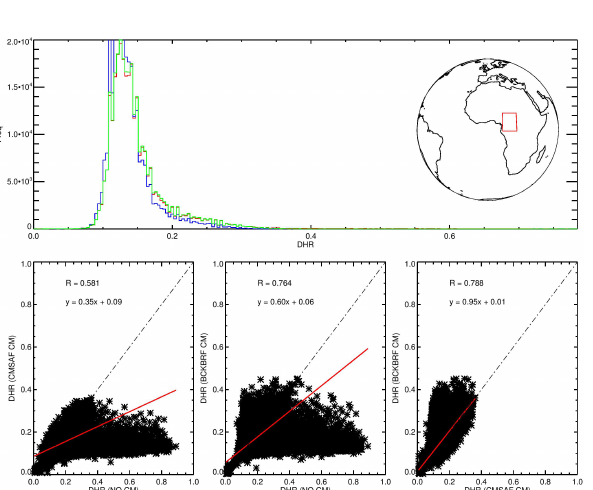
Figure 12. Same as Fig. 10 but for a tropical forest area viewed under high view zenith